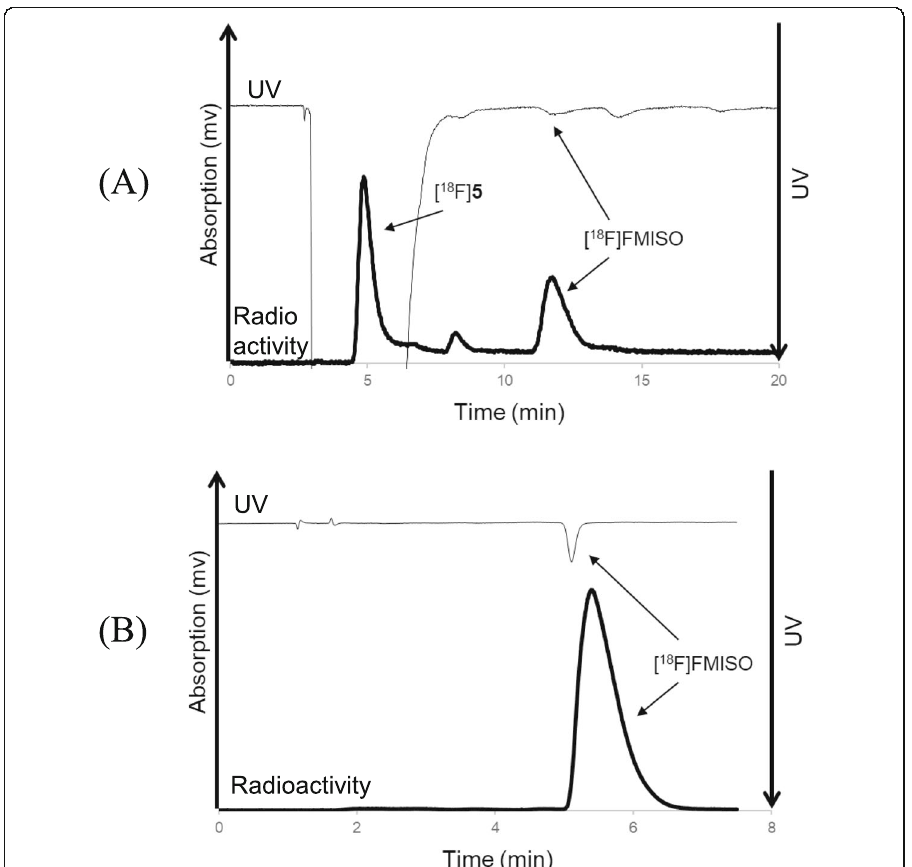
Fig. 5 Preparative HPLC ( A ) and analytical HPLC ( B ) chromatograms of [ 18 F]FMISO by 18 F-fluoroalkylation using [ 18 F]5. The preparative HPLC conditions were as follows: XBridge C 18 column (5 μ m, 10 mm i.d. × 250 mm length; Waters), a mixture of ethanol and water (2:98, vol./vol.) as the mobile phase, 5.0 mL/min flow rate, and UV detection at 325 nm. The retention time of [ 18 F]FMISO was approximately 12 min ( A ). The analytical HPLC conditions were as follows: XBridge C 18 column (5 μ m, 4.6 mm i.d. × 150 mm length; Waters), a mixture of 90%